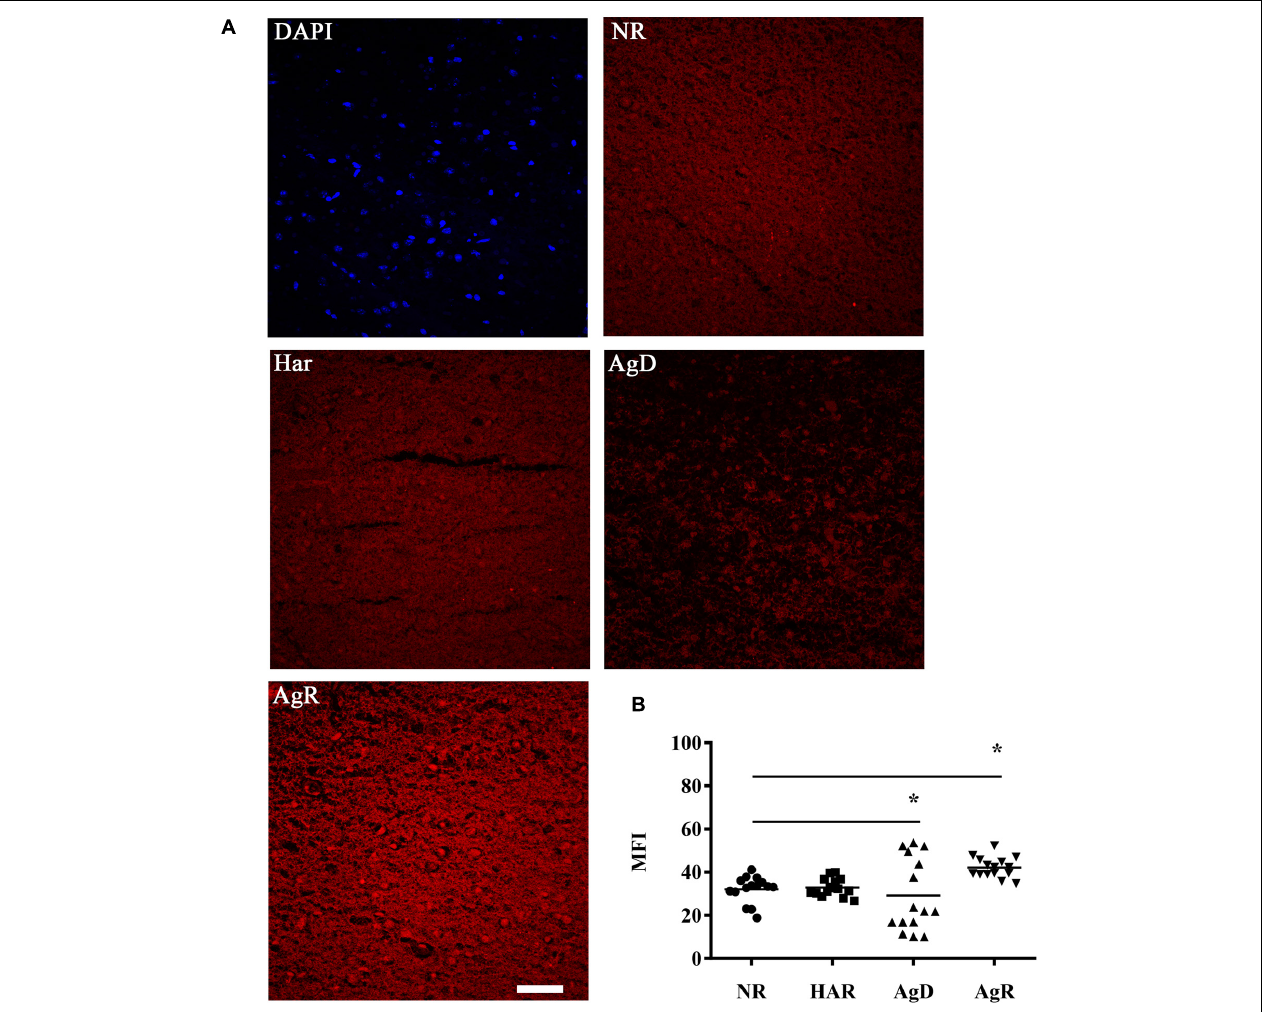
FIGURE 7 | Evaluation of superoxide production in the cerebral frontal cortex of mice submitted to the MSA. (A) Representative image showing the production of superoxide staining (red) through the reaction of DHE with superoxide present in the tissue of the frontal cortex region in the categories not regrouped (NR), harmonic (Har), defeated (AgD) and aggressive (AgR). Bar: 50 urn. (B) Individual comparison of the mean fluorescence intensity (MFI) of the mice according to the categorization of animals in NR (black circle), Har (black square), AgD (black triangle) and AgR (inverted black triangle) animals in the cerebral frontal cortex (NR; n = 15, Har; n = 18, AgD; n = 15, AgR; n = 15 animals). The values are expressed according to the MFI provided by the Image J software from three independent experiments. * corresponds to statistical significance ( p < 0.05) between AgR and the other categories and between AgD and NR and Har by Kruskal-Wallis and Dunn’s